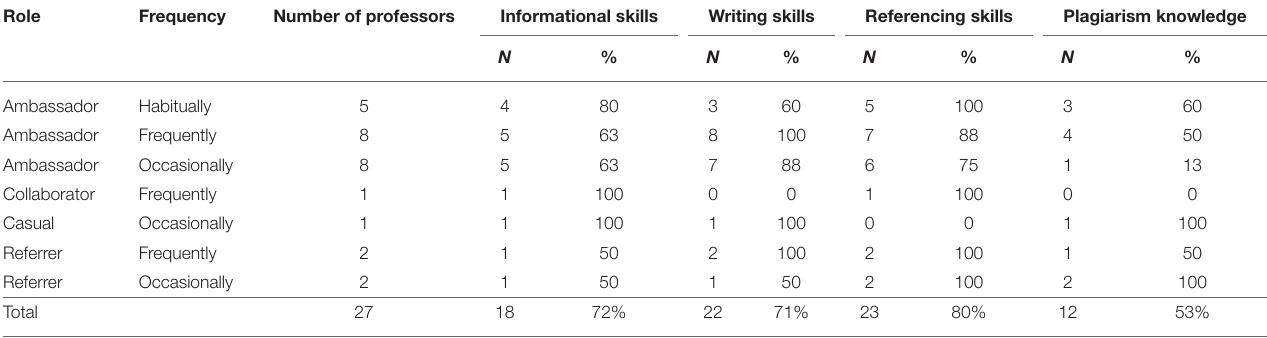
TABLE 6 | Frequency of the roles for the teaching of skills and knowledge by the professors.